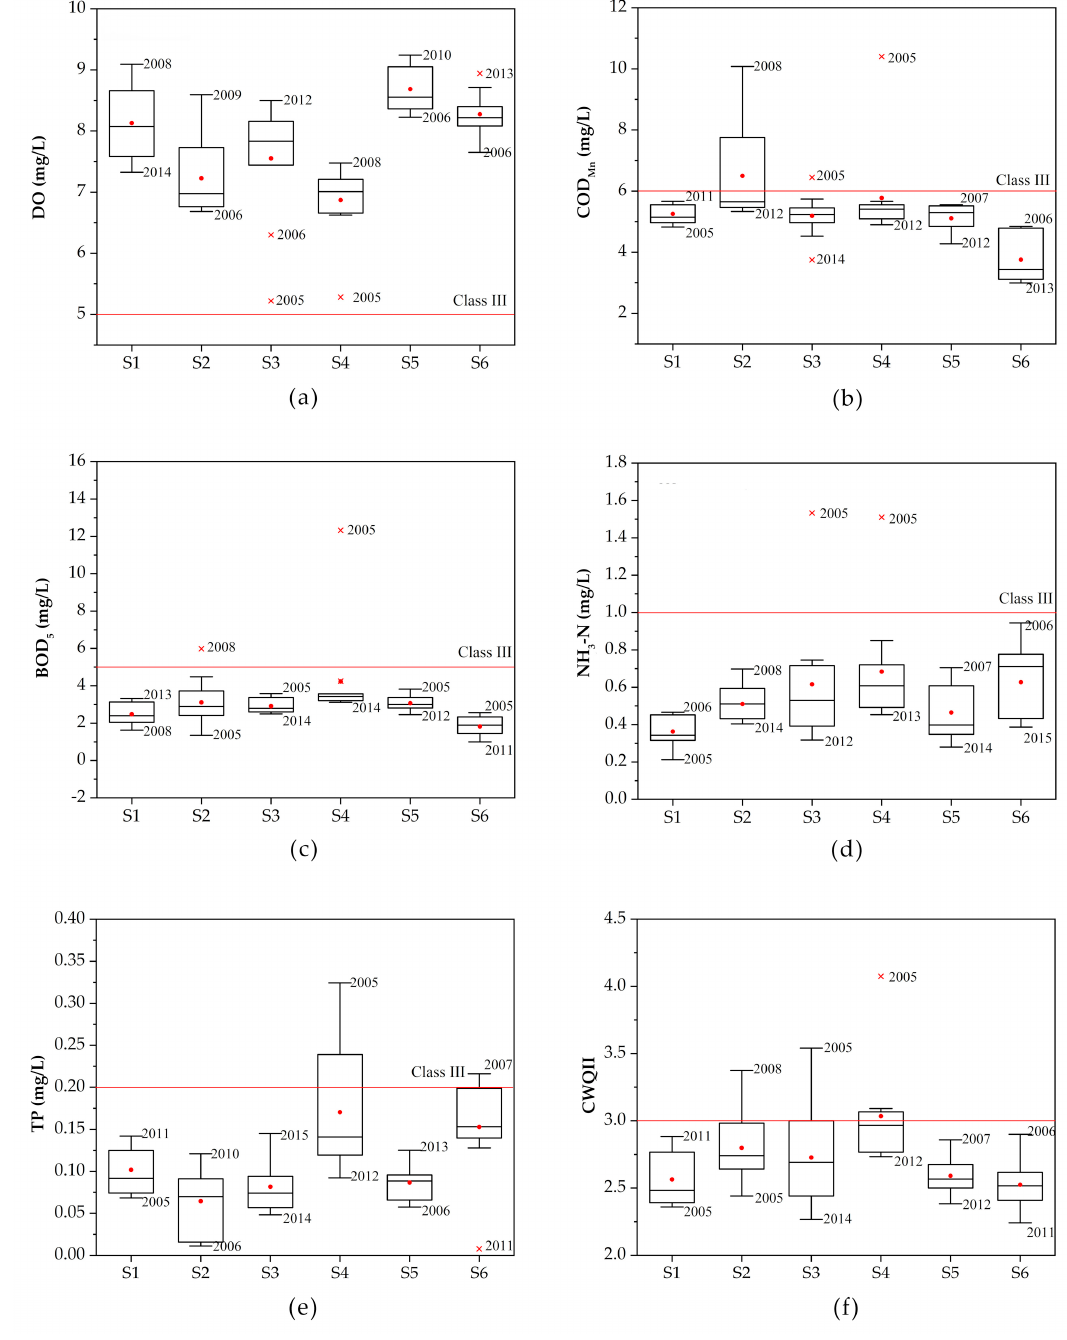
Figure 2. Box plots of ( a ) DO, ( b ) COD Mn , ( c ) BOD 5 , ( d ) NH 3 -N, ( e ) TP, and ( f ) CWQII (comprehensive water quality identification index) for the six sites in Xuzhou section. The year when the maximum and minimum values of each water quality parameter occurred are marked in the box